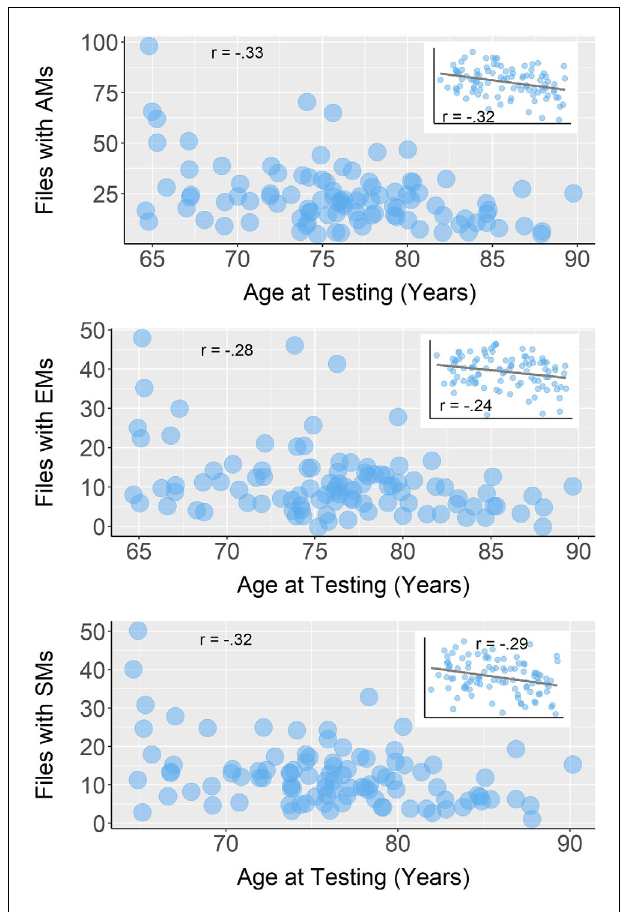
FIGURE 2 | Correlations between age and (A) sound files with autobiographical memories (AMs), (B) sound files with episodic memories (EMs), and (C) sound files with semantic memories (SMs). Raw data and correlation coefficients of the bivariate Spearman correlations are represented in the larger plots. The partial Spearman correlations are shown in the small plots with regression lines. For all three partial correlations, we used a covariate of the number of sound files where participants were engaged in conversation.